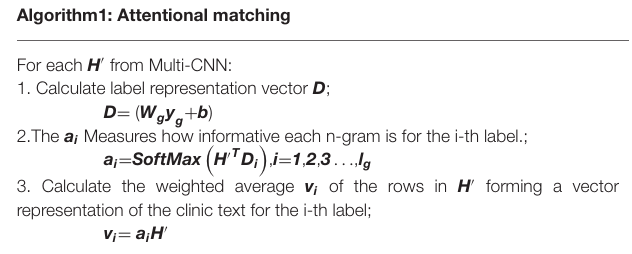
TABLE 2 | The algorithm details of attentional matching. Algorithm1: Attentional